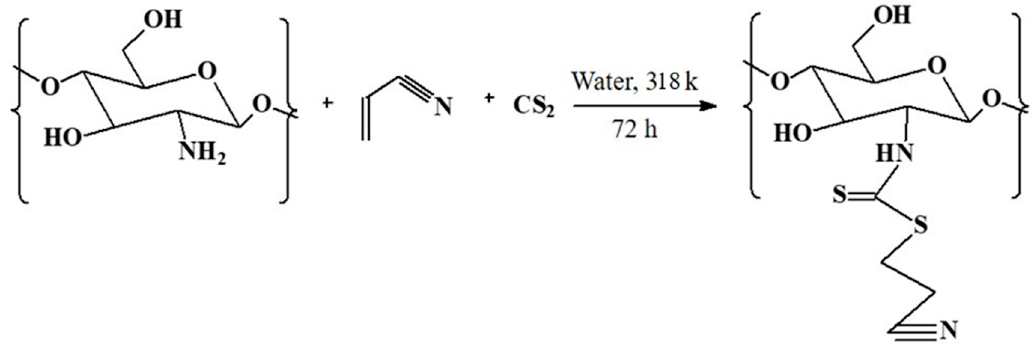
Figure 6. The proposed reaction mechanism for chitosan modification using acrylonitrile (AN) in the presence of carbon disulfide. Triethylamine was additionally supplemented to the suspension as a catalyst.